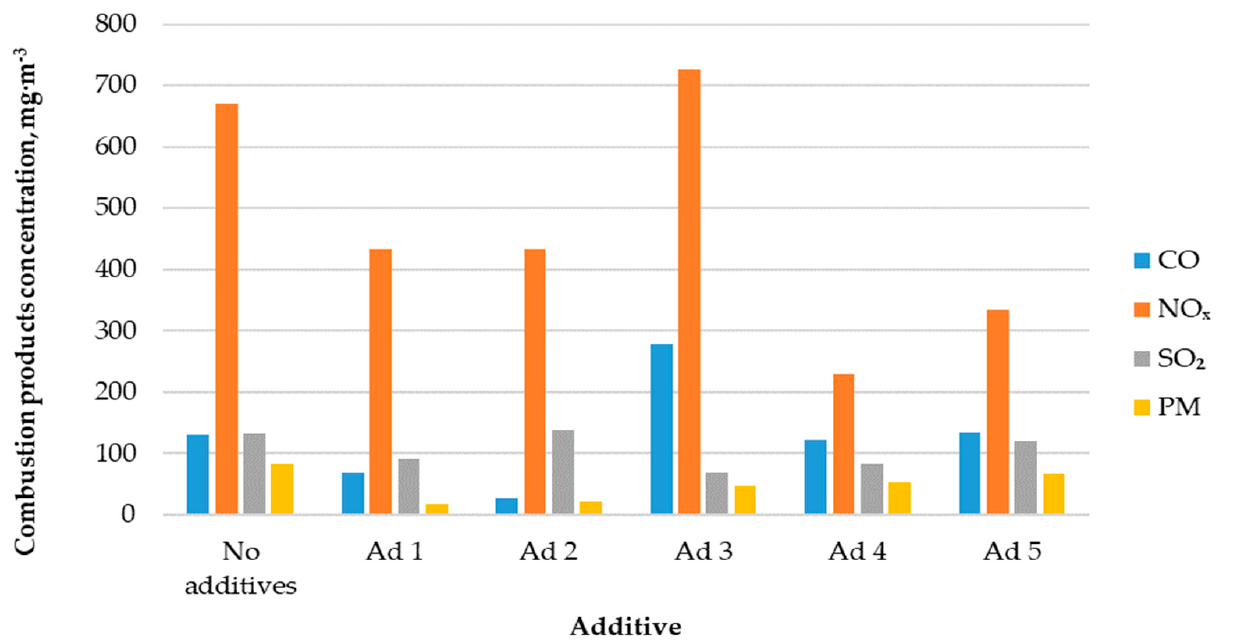
Figure 4. Concentration of combustion products in the exhaust gases.